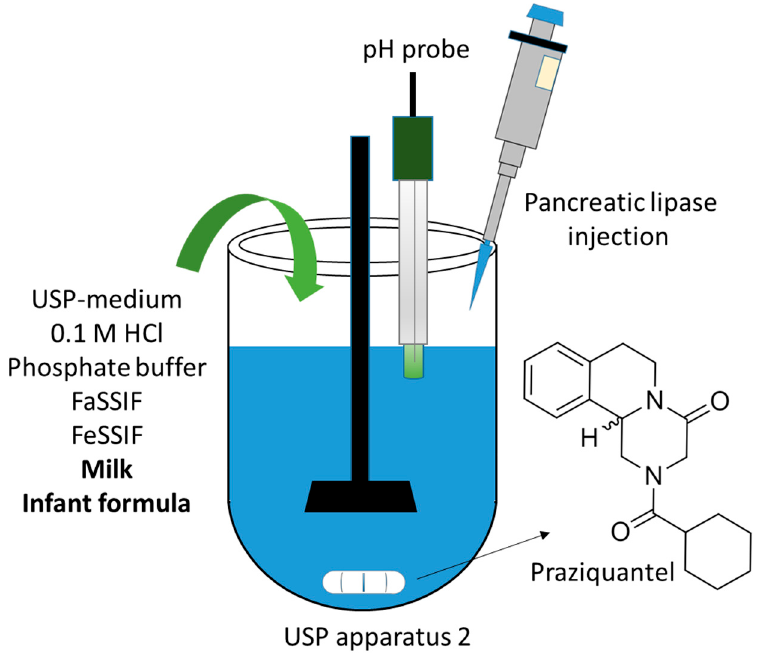
Figure 1. Schematic representation of the concept of this study. Dissolution of praziquantel was studied in a range of different media including in milk and infant formula during digestion.